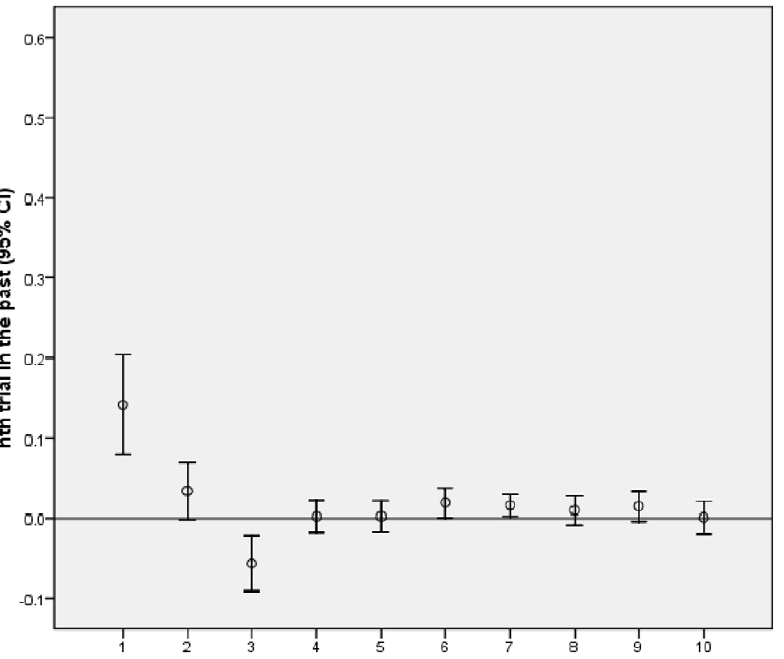
Figure 3. Results for testing normal controls. Correlation of current prediction with what happened on the nth trial in the past plotted against trials into the past (n).